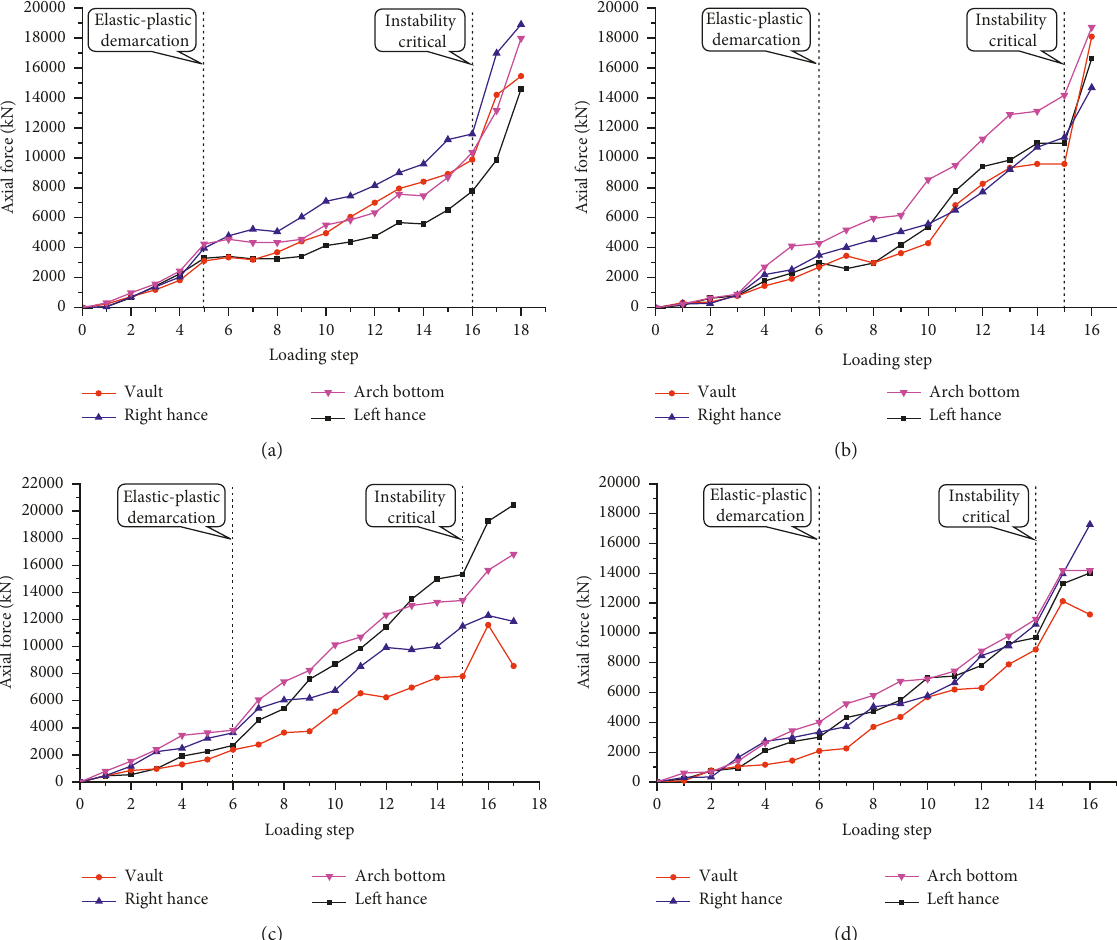
Figure 13: Load-axial force curves at key points of lining. Variation curve of axial force for (a) group 1, (b) group 2, (c) group 3, and (d) group